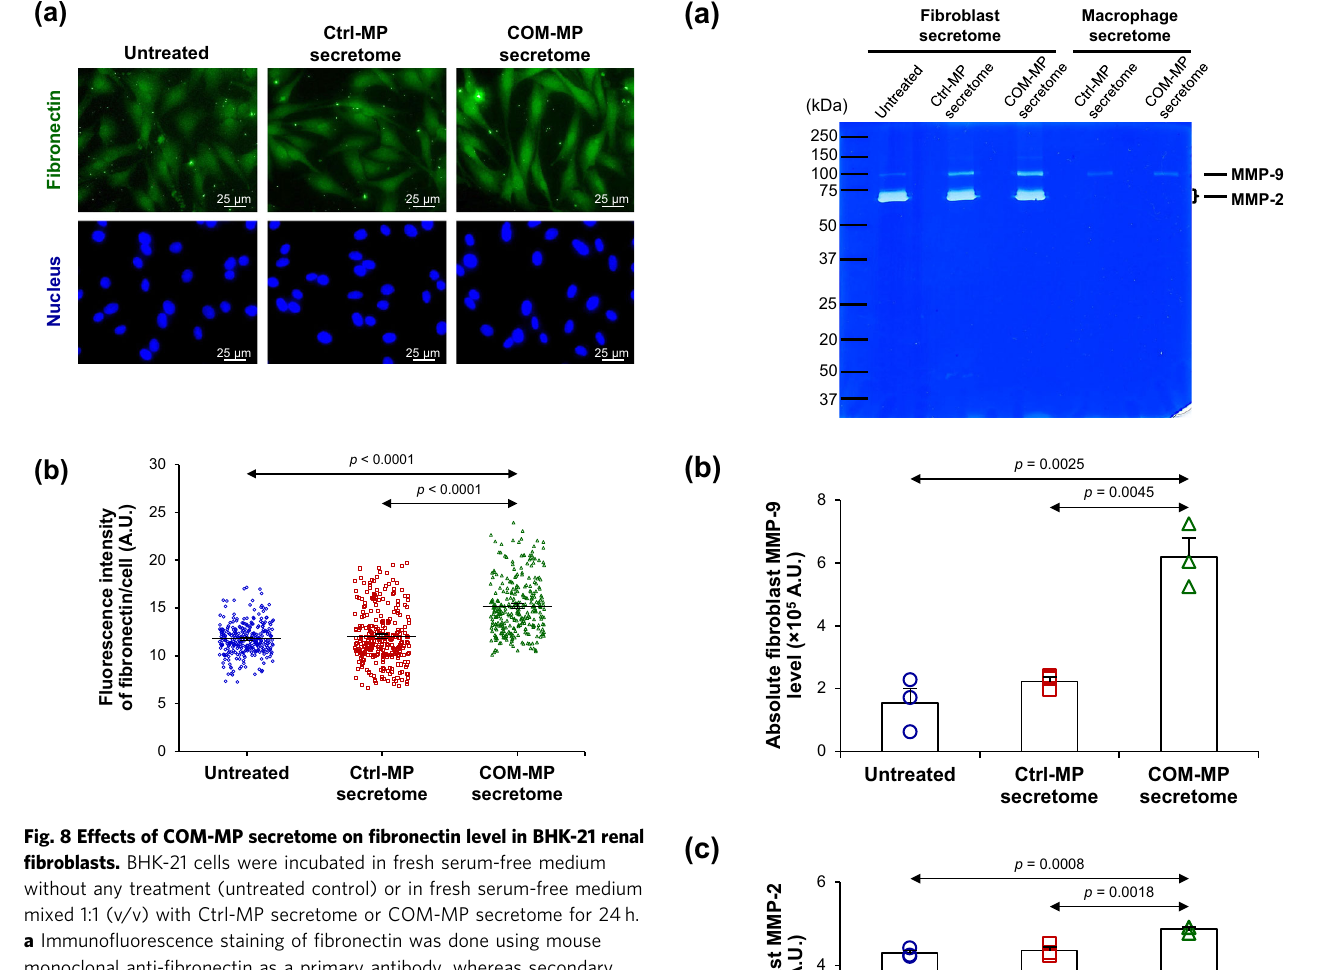
598 secretory proteins, label-free quantitative proteomics analysis